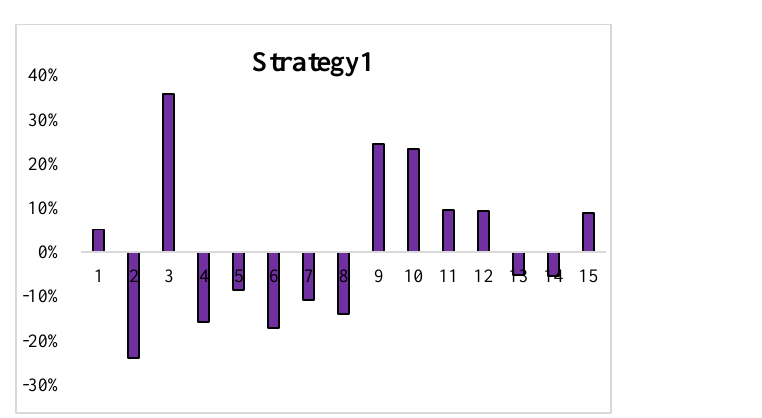
Fig2. Returns for 15 pair trades using strategy 1 in the out-of-sample